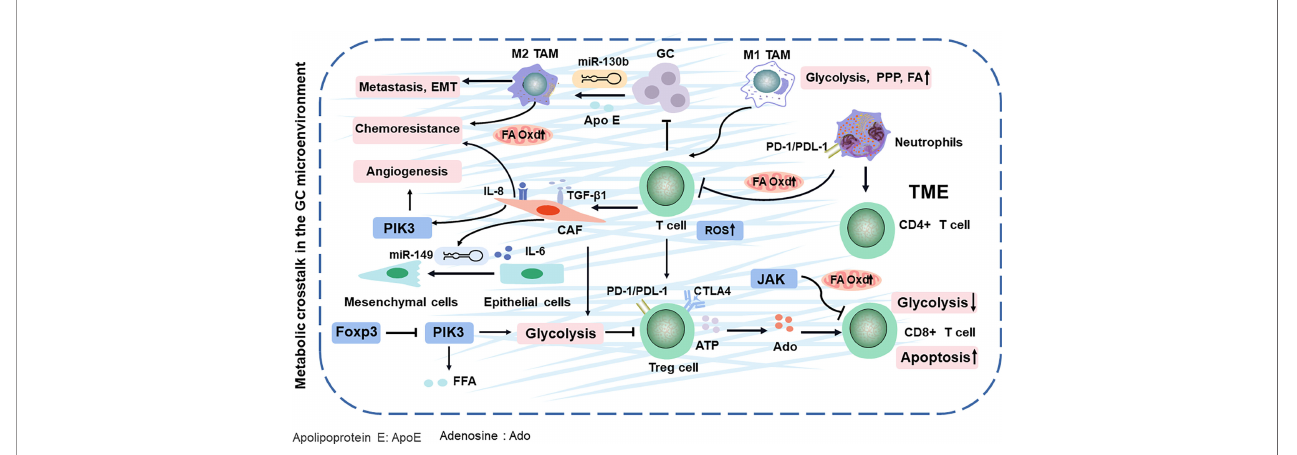
FIGURE 2 | TME comprising the tumor cells and various stromal cells in GC. They evade immune surveillance during GC progression by balancing energy requirements and in TME. Finally, the metabolites of TME impacts cancer-speci fi c or related phenotypes. Apo E, apolipoprotein E; Ado, adenosine; Oxd, oxidation; PPP, pentose phosphate pathway; ROS, reactive oxygen species; TAM, tumor-associated